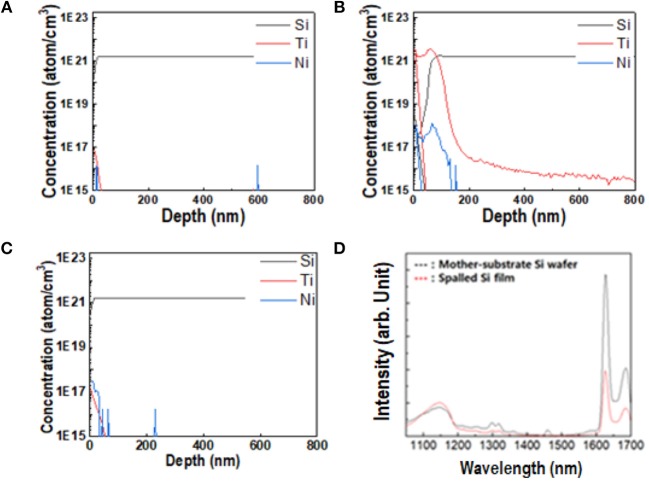
Physical properties of spalled Si wafer. (A–C) Atomic concentration of Si, Ti, and Ni at various vertical positions in different samples: (A) pure Si mother substrate; (B) spalled Si wafer after etching without HF; (C) spalled Si wafer after etching with 25 mL/L HF. (D) Comparison of PL of spalled Si wafer (red line) with that of pure Si mother substrate (black line).